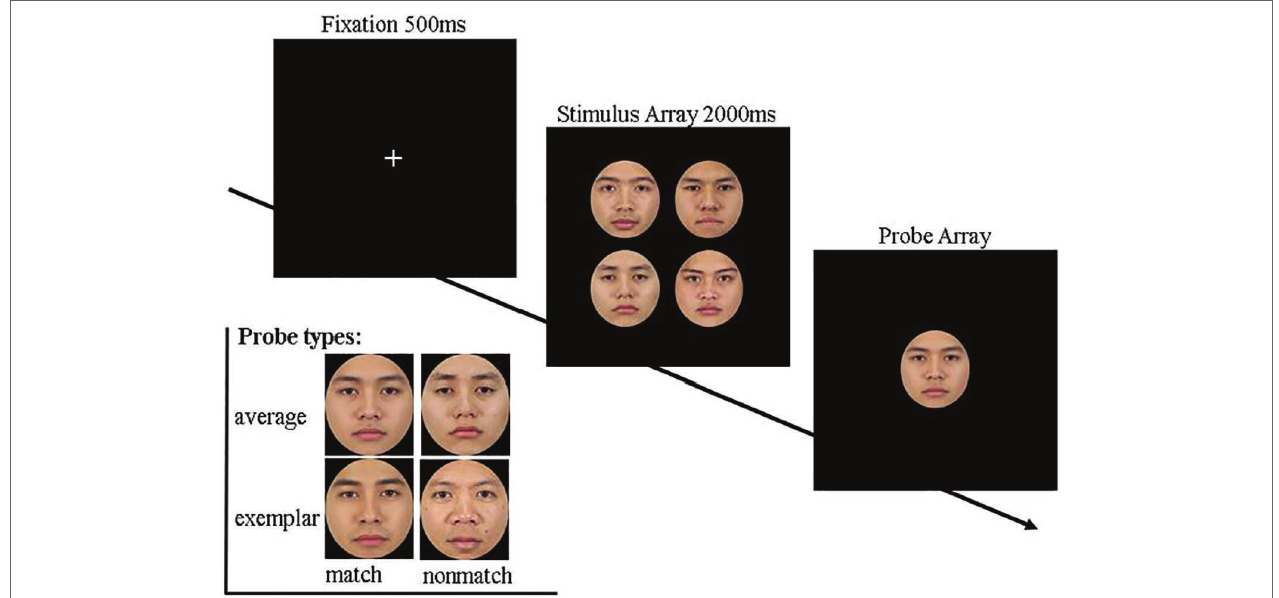
FIGURE 1 | A schematic presentation of the ensemble coding task (top) and the probe types (below). Each trial began with a fixation (500 ms) and a stimulus array containing four original faces (2,000 m). Next, in the probe array, participants had to indicate whether the probe face had been “present” or “absent” in the prior array by pressing the “F” (present) or “J” (absent) key. The probe face could be either a morphed average face (set average) or a member face (exemplar), and could have been taken either from the preceding stimulus set (match condition) or from another set (nonmatch